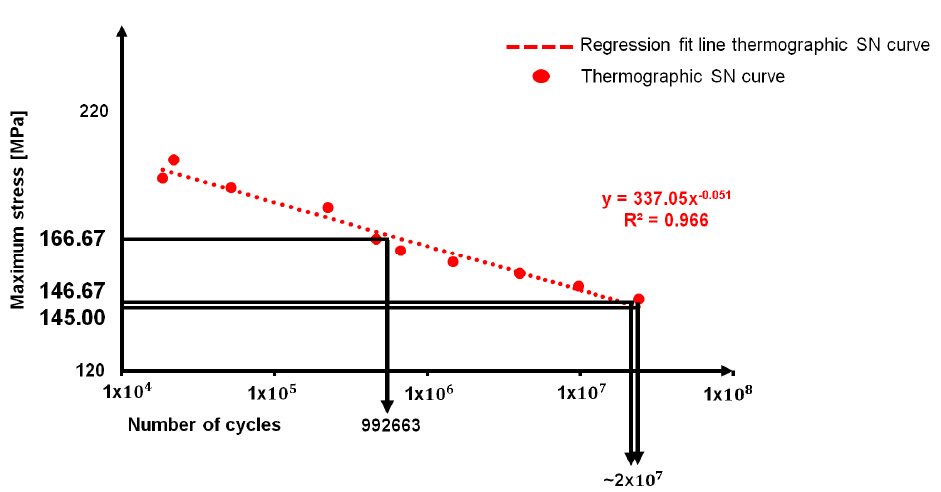
Figure 12. Assessment of the fatigue strength of AA5754-H111 by using the data from threshold method and thermographic S-N curve.